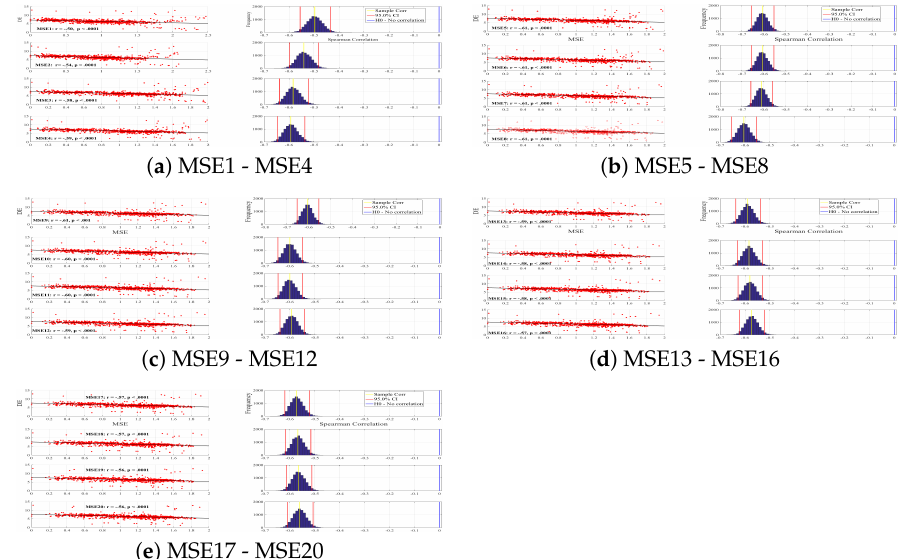
Figure A7. Negative mental state. Spearman correlation between participants’ DEs (i.e., 62 DEs associated with 62 EEG channels of a participant, per affect) and their corresponding MSE1s (i.e., 62 MSE1s associated with 62 EEG channels of a participant, per affect) through MSE20 values (i.e., 62 MSE20s associated with 62 EEG channels of a participant, per affect). The subplots in the right column correspond to bootstrap correlation test (10,000 simulation runs) at 95.0% confidence interval. The values associated with these subplots are summarized in Table A7.